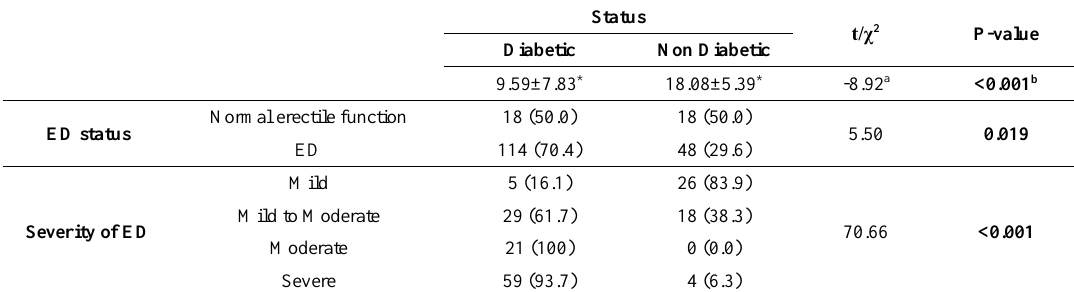
Table 2. Prevalence and severity of erectile dysfunction in by diabetes status